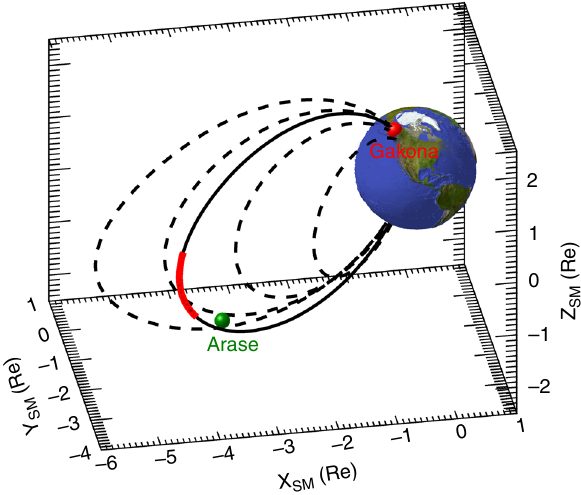
Fig. 3 Magnetic latitude range of the wave – particle interaction region. The black solid curve is the magnetic fi eld line connected to the auroral fl ash observed at Gakona. Dotted curves are magnetic fi eld lines for the L-values of 3, 4, 5, and 6 for reference. The green symbol indicates Arase ’ s